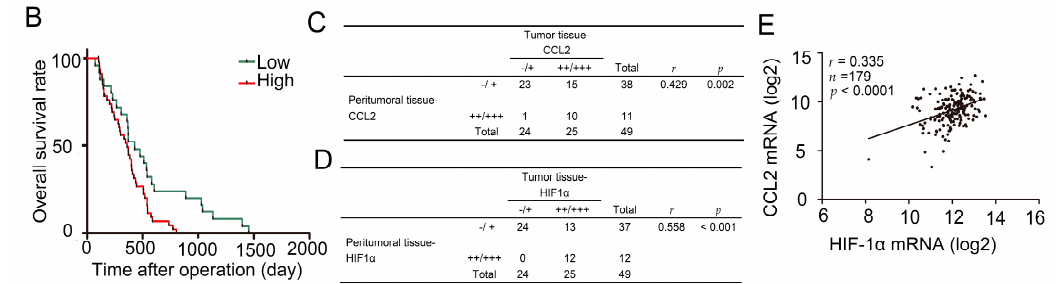
Figure 2. The correlation between HIF-1 α and chemical chemokines 2 (CCL2) expression in specimens of PDAC. ( A ) Immunohistochemical analysis of HIF-1 α and CCL2 correlative expression in consecutive sections from human PDAC surgical samples (tumor tissue and peritumoral tissue). Left, low expression (intensity grade − and +). Right, high expression (intensity grade ++ and +++) (magnification, 100 or 200); ( B ) Association between CCL2 expression levels and the overall survival of patients with PDAC. Patients with PDAC (131) were stratified into two groups according to CCL2 IHC staining intensity. Patients with high CCL2 expression (intensity grade ++ and +++) had much worse overall survival when compared with patients with low CCL2 expression (intensity grade − and +). p = 0.014 was determined with a log-rank test; ( C ) Statistical analysis of immunohistochemical results of CCL2 expression in tumor tissue and peritumoral tissue. p Value was calculated by the Spearman rank correlation test; ( D ) Statistical analysis of immunohistochemical results of HIF-1 α and CCL2 expression in 131 human PDAC surgical samples. p Value was calculated by the Spearman rank correlation test; ( E ) Analyzed mRNA expression profiles of HIF-1 α and CCL2 in 177 PDAC patients from TCGA.